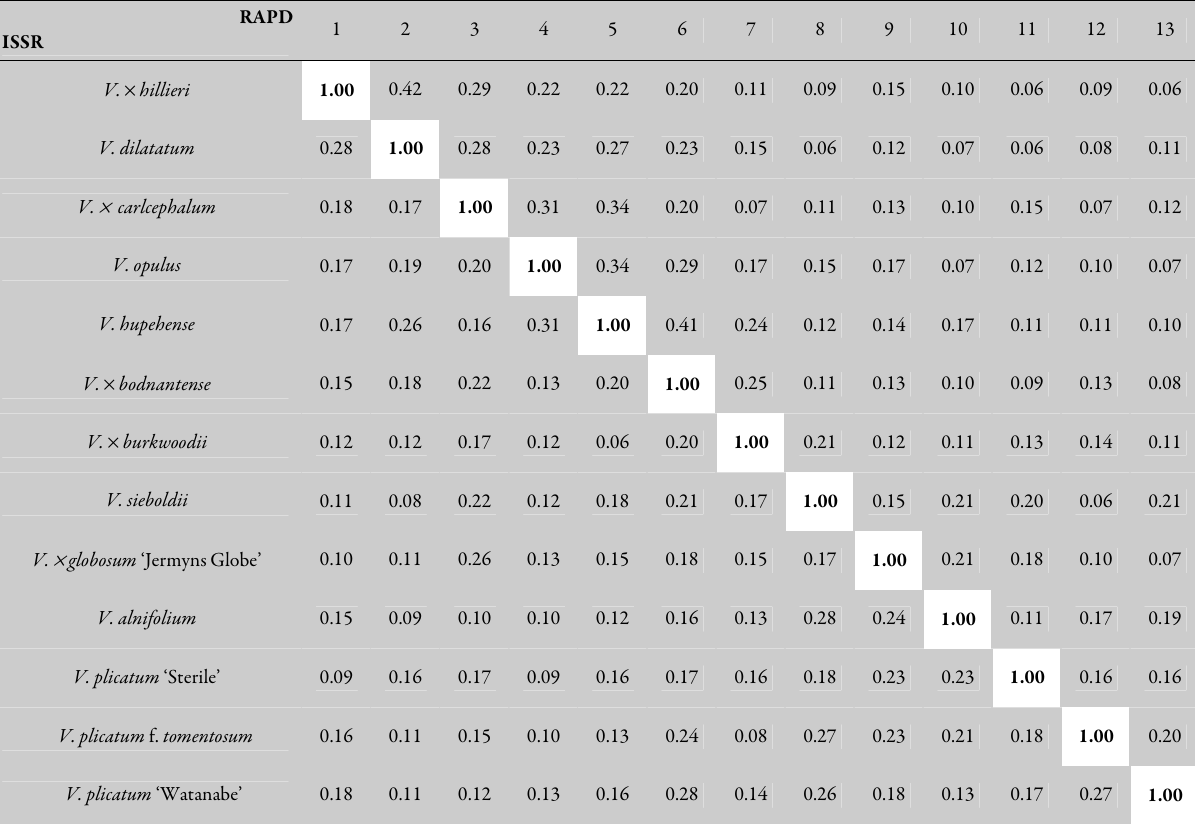
Tab. 4. Similarity matrix of 13 Viburnum genotypes based on RAPD and ISSR markers